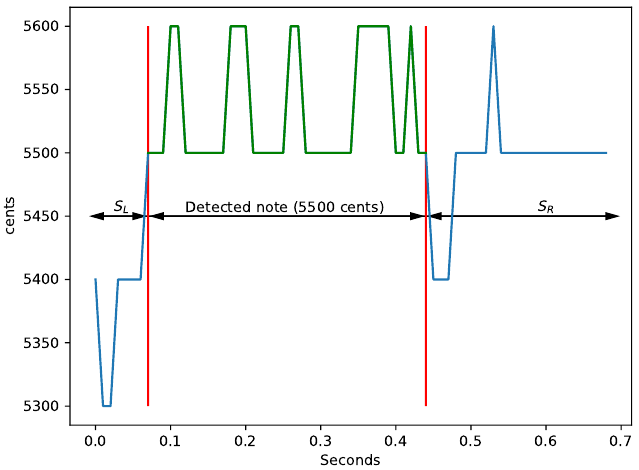
Figure 4. Detected musical note and new split